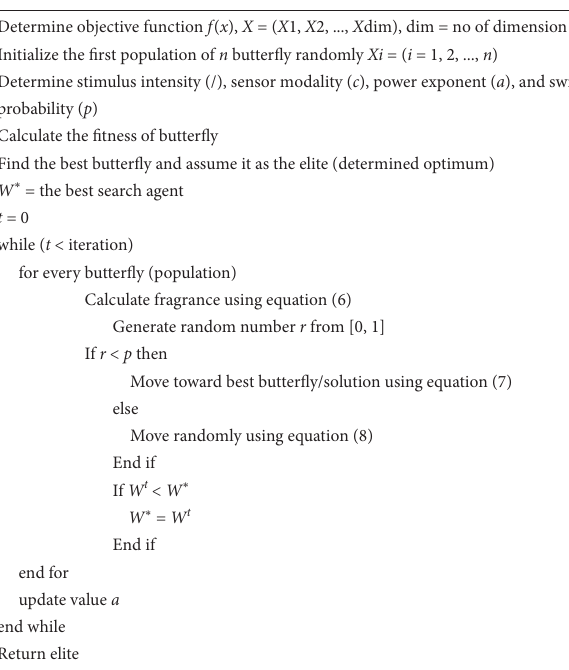
Figure 1: Pseudocode of butterfly optimization algorithm